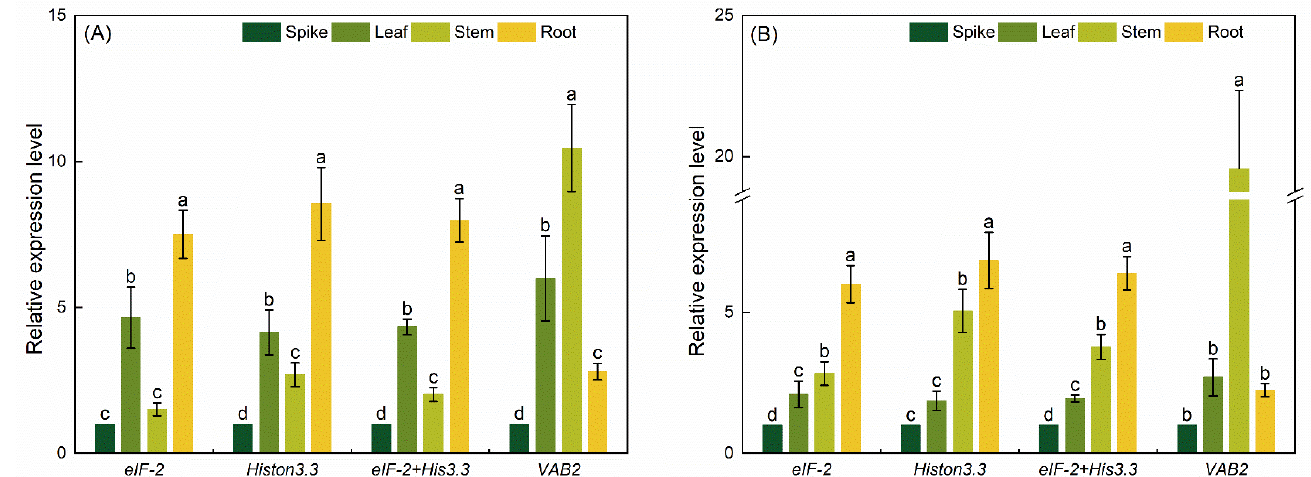
Figure 6. Validation of the identified reference genes. Relative expression of ( A ) PvTAT and ( B ) Pv4CL2 in different organs of P. vulgaris that normalized by the most stable reference genes eIF-2 , His3.3 , eIF-2 + His3.3 , and the least stable reference gene VAB2 . The different letters signified significant differences at p < 0.05 by LSD test.